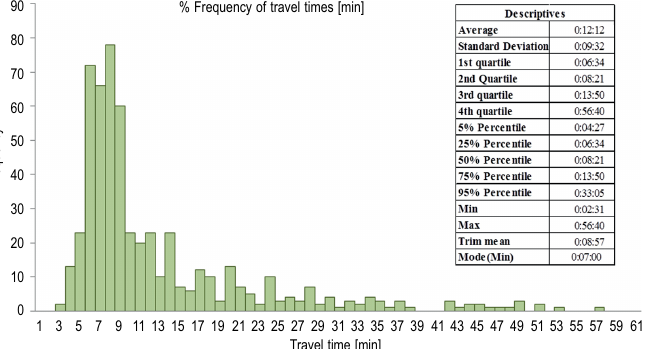
Fig. 11. Travel time distribution and descriptive statistics